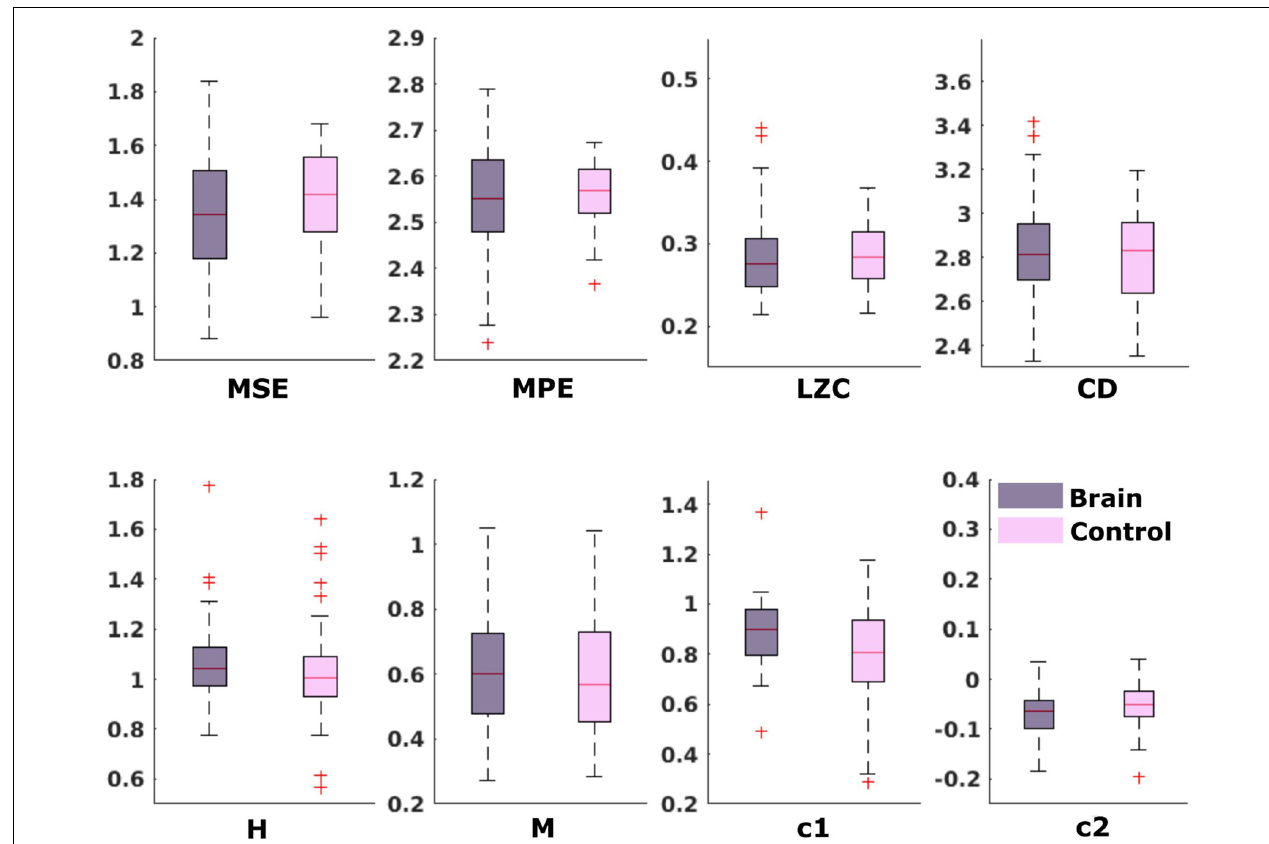
FIGURE 9 | Results from analysis of different metrics on data from fetuses without stimulation. No significant differences after Bonferroni